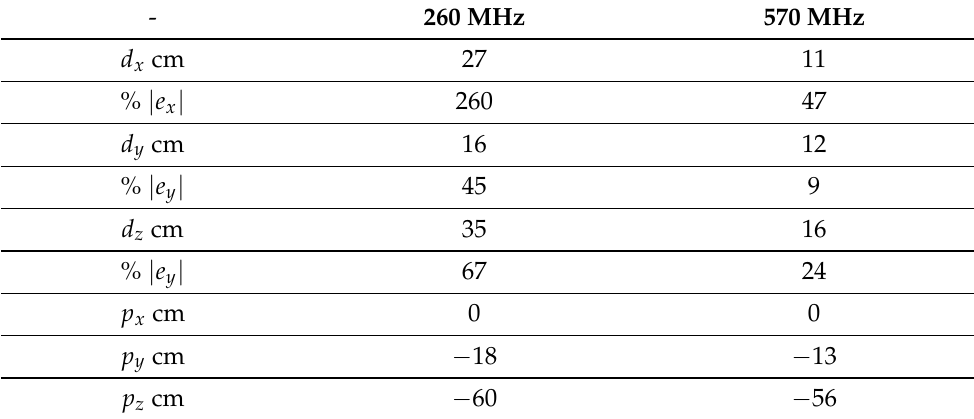
Table 3. NFLA Imaging Results Target Metrics. Target’s size and position, obtained by imaging with NFLAs, while the target is close to antenna 3. The absolute value of percentage error in dimension detection has been represented as